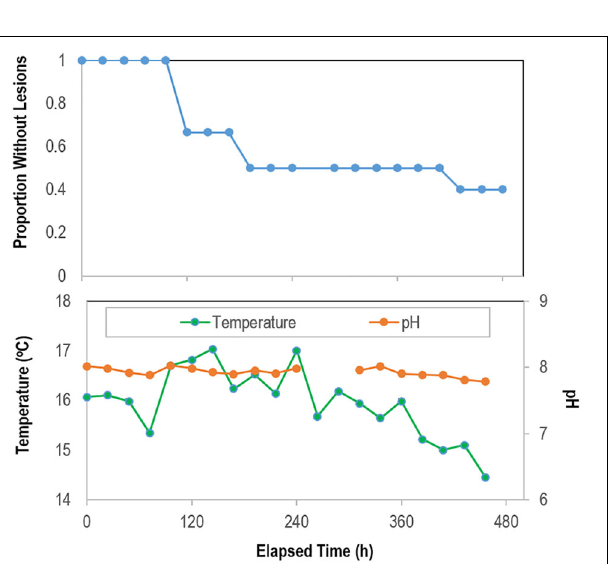
FIGURE 7 | Proportion of grossly normal Asterias forbesi ( n = 12 per treatment) incubated in normoxic and depleted oxygen water (top) and variation in temperature and O 2 in incubation aquaria (bottom) over time. The red arrows at top indicate samples which were included in analysis of microbiome composition (see Supplementary Figure S6